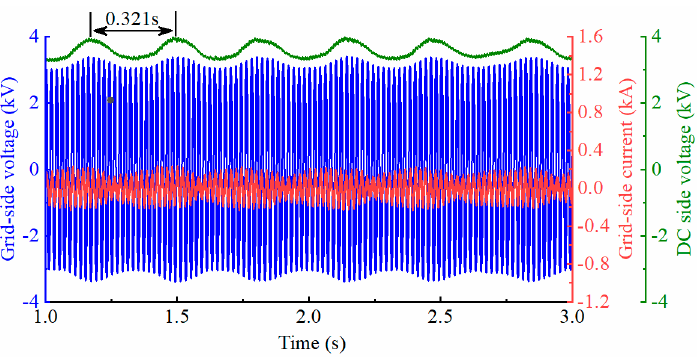
Figure 16. Grid-side voltage and current waveforms when a single CRH5 vehicle was connected.